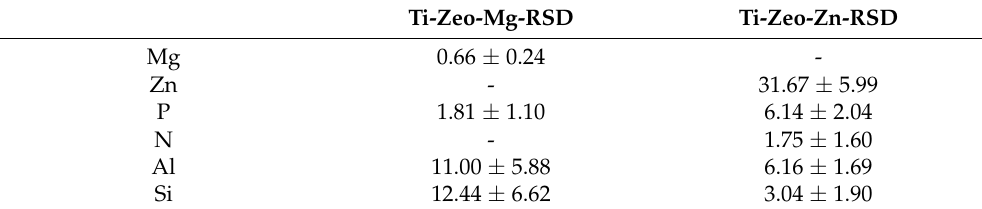
Table 1. The content of elements in materials after drug sorption (wt.